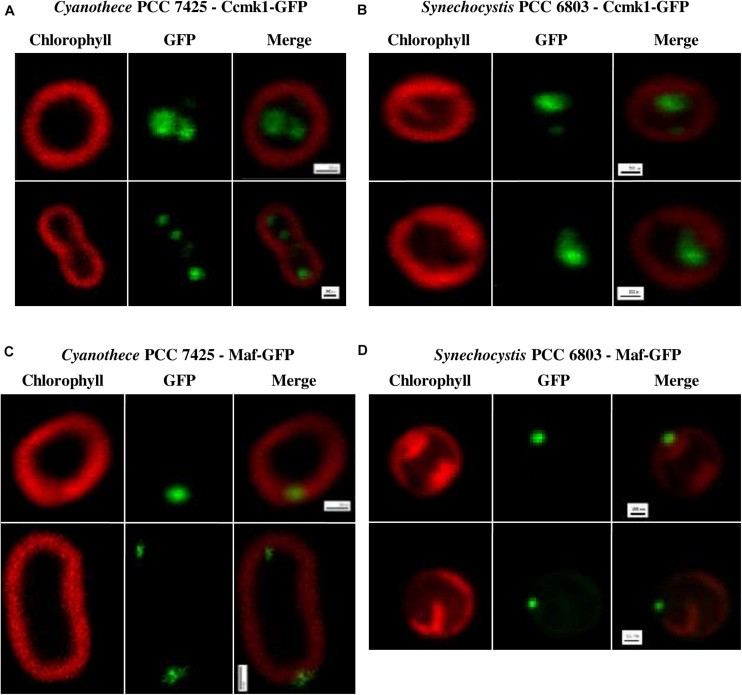
Localization of the fusion proteins Ccmk1tsbp1-GFP and MafS6803-GFP in Cyanothece PCC 7425 and Synechocystis PCC 6803. Fluorescence images (scale bars, 500 nm) of Cyanothece PCC 7425 and Synechocystis PCC 6803 reporter cells propagating the plasmids pSB2T-ccmk1tsbp1-gfp (A,B) or pSB2T-mafS6803-gfp (C,D), respectively.